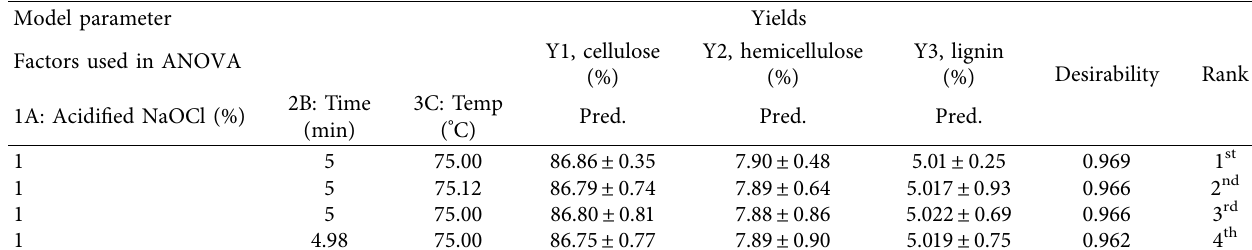
Table 2: Description of the first four optimized predicted solutions of the RSM quadratic model Design matrix for the first-step bleaching treatment. Model